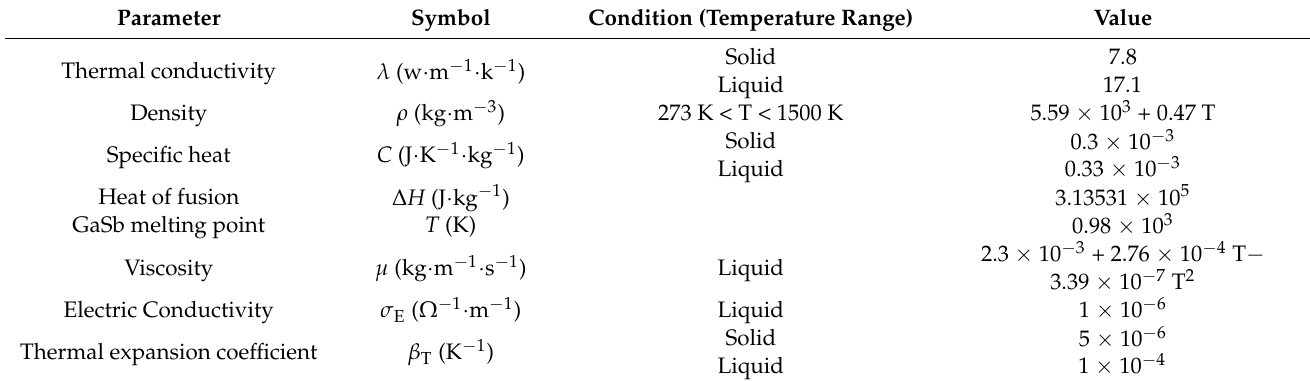
Table 1. Physical parameter of Ga 1 − x In x Sb [18–20].